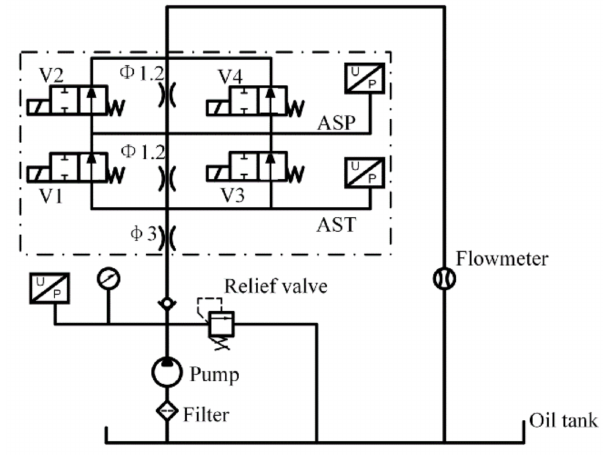
Figure 5. Schematics of hydraulic testing system.